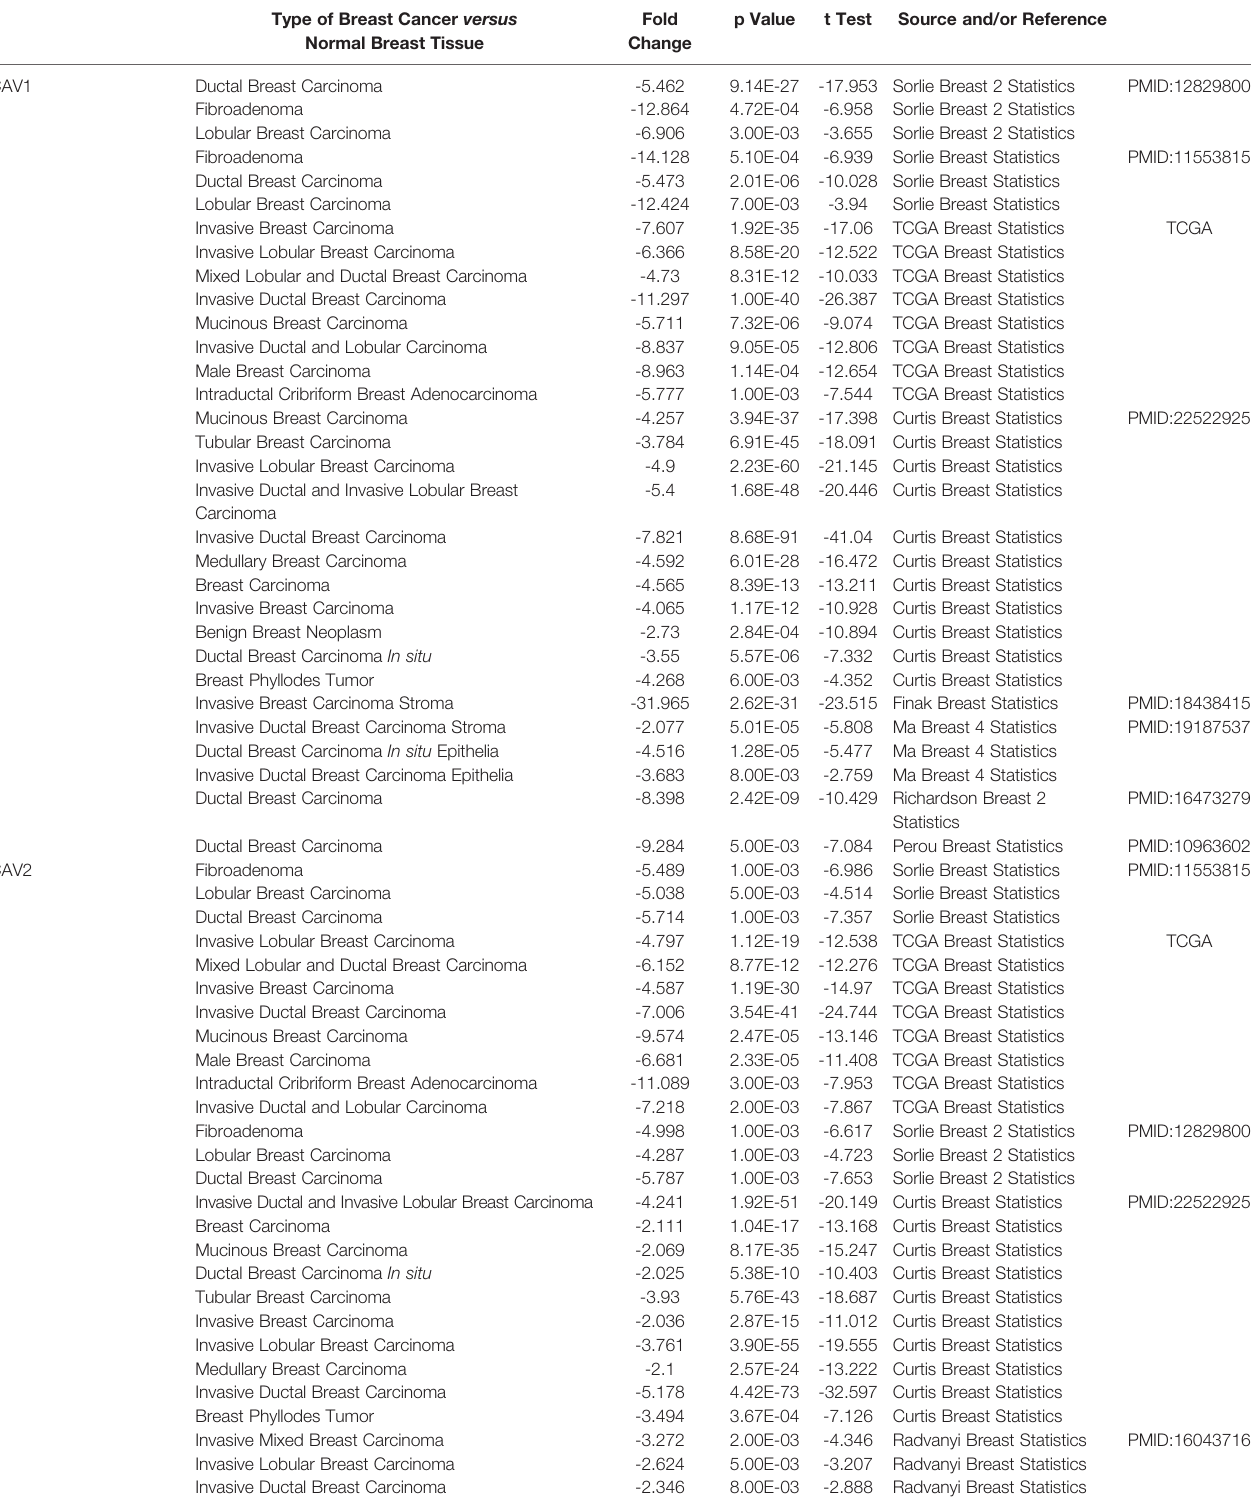
TABLE 1 | Signi fi cant expression changes of caveolae-related proteins in transcription levels between different types of breast cancer and normal breast tissues (Oncomine